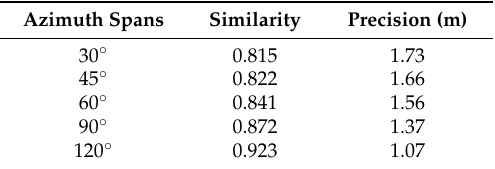
Figure 5. The simulated projections of B4 in different views. Table 3. Performance of DMPCA on different cases of equidistant azimuth spans.